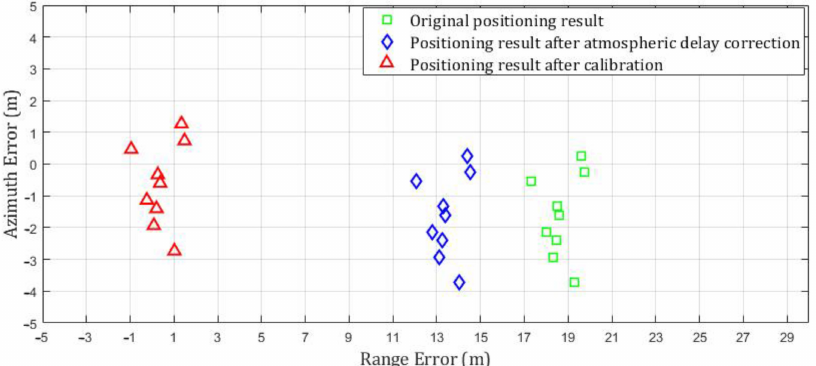
Figure 13. Positioning results of Test image 3 without any error correction, after atmospheric delay correction and after calibration